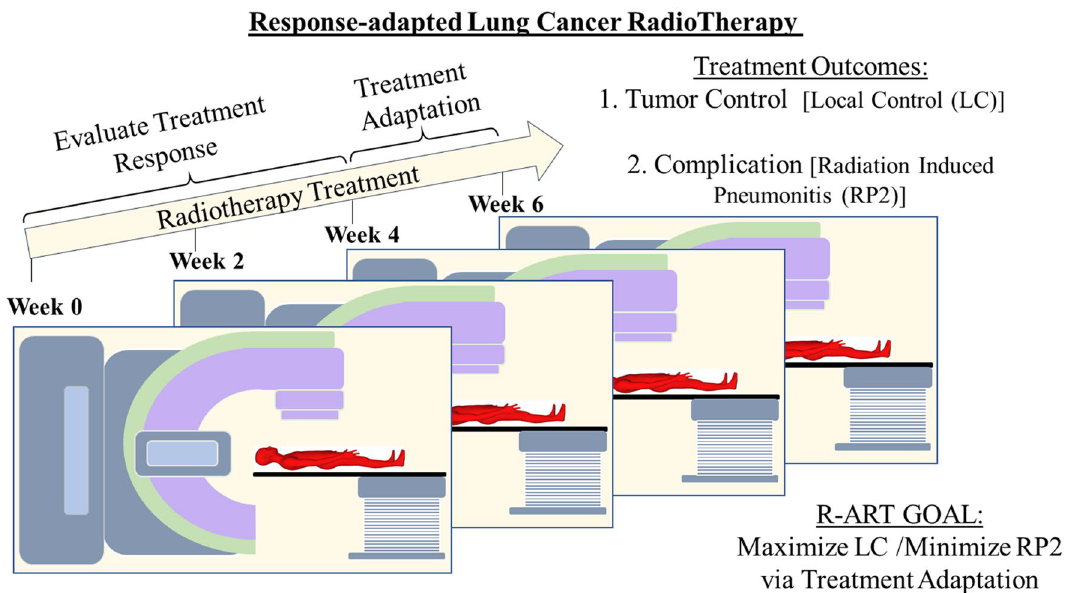
Figure 1. Schematics of response-adapted lung cancer radiotherapy. Response-adapted radiotherapy evaluates treatment response in the first two-thirds (week 1 to week 4) of the treatment period and then makes necessary adaptation in the last third (week 5 to week 6), with the goal of optimizing the treatment plan. For the case of lung cancer, optimization translates into maximizing tumor (local) control (LC) and minimizing radiation- induced pneumonitis of grade 2 or higher